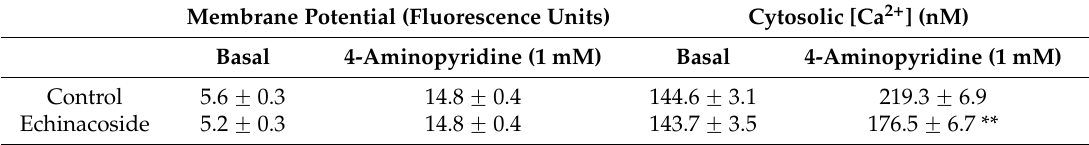
Table 1. Effect of echinacoside on membrane potential and cytosolic Ca 2+ levels from rat cortical synaptosomes.